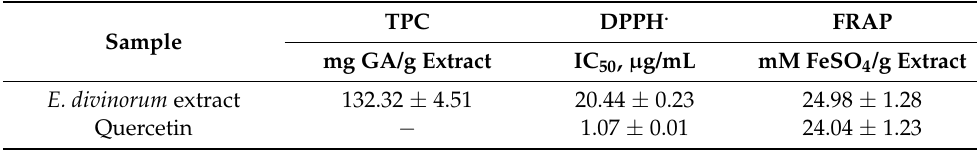
Table 8. In vitro antioxidant activities and total phenolic content.